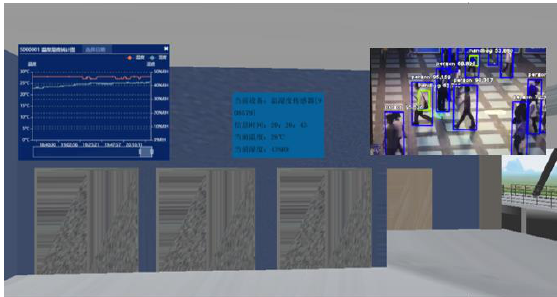
Figure 9. Interface rendering for safety status monitoring with a scene.